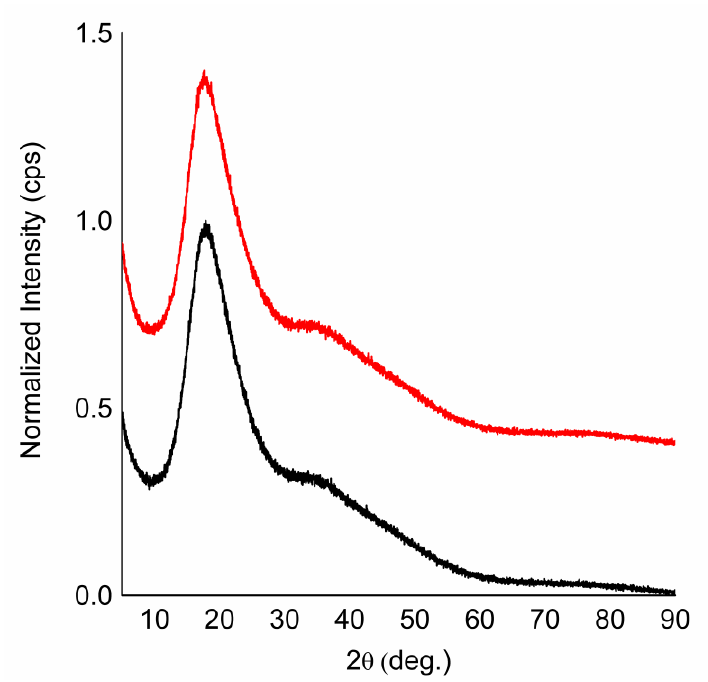
Figure 8. X-ray diffractograms of honey (red) and GFSw (black). The diffractograms could be deconvoluted by Gaussian decomposition in up to four apparent peaks, at approx. 2 θ = 17.58 ◦ /17.8 ◦ , 35.9 ◦ /35.01 ◦ , 44.2 ◦ /46.2 ◦ , and 78.3 ◦ /78.1 ◦ , A B